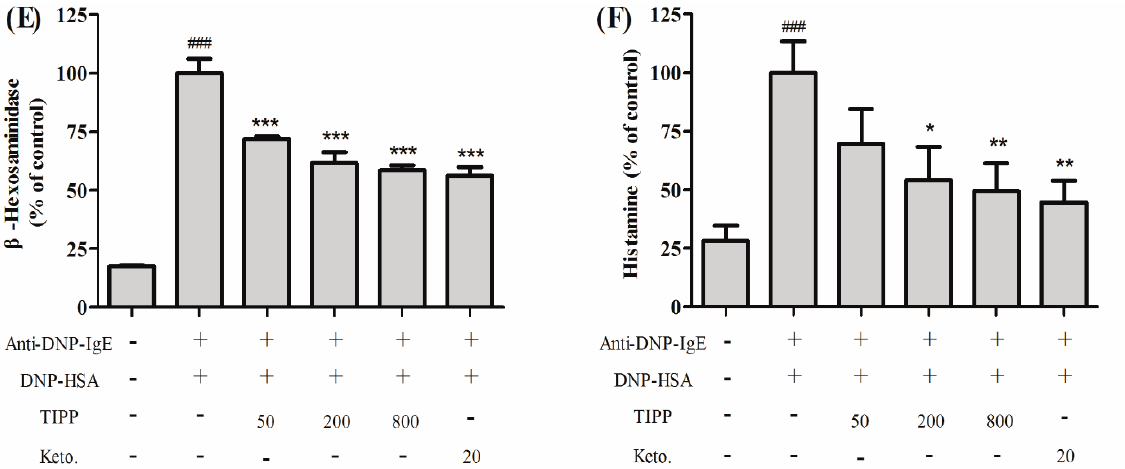
Figure 2. Effect of thymic immunosuppressive pentapeptide (TIPP) on